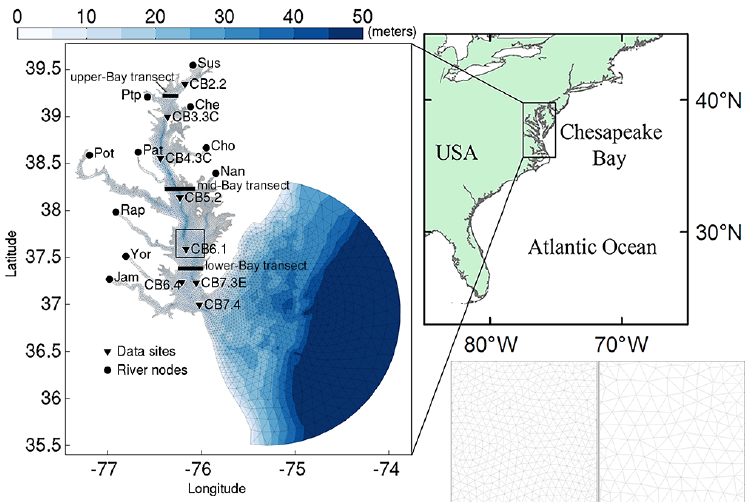
Figure 1. Model grid and bathymetry of Chesapeake Bay (CB) and its adjacent coastal ocean with river nodes, data sites and three transects. The bottom right panels are the zoom-in of the boxed area from two sets of grids generated for sensitivity experiments on spatial resolution. Sus, Susquehanna River; Ptp, Patapsco River; Che, Chester River; Pat, Patuxent River; Cho, Choptank River; Pot, Potomac River; Nan, Nanticoke River; Rap, Rappahannock River; Yor, York River; Jam, James River.